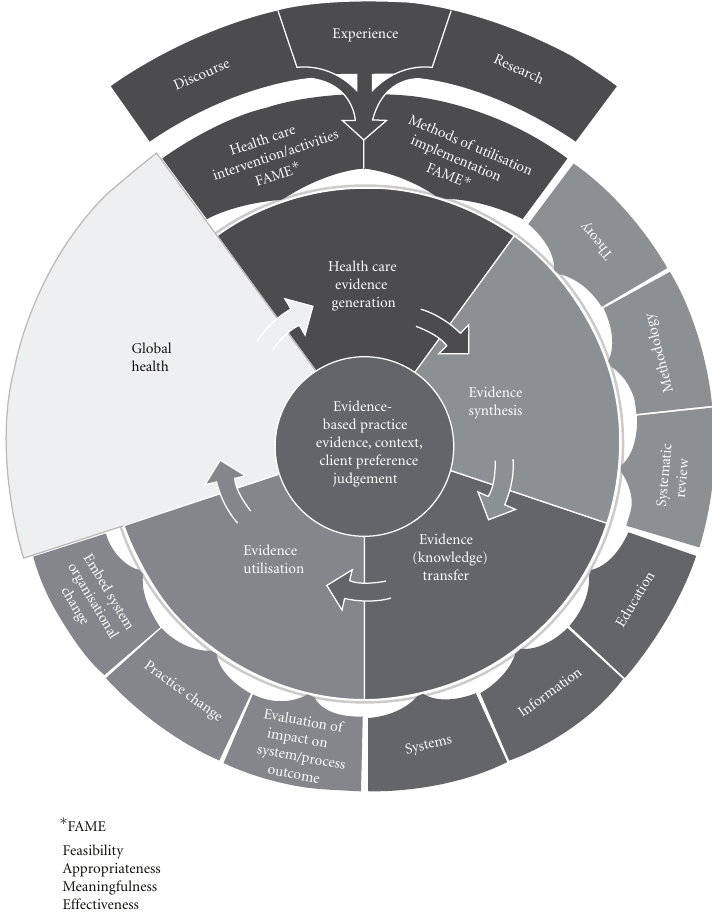
Figure 1: The JBI Model of Evidence-Based Healthcare